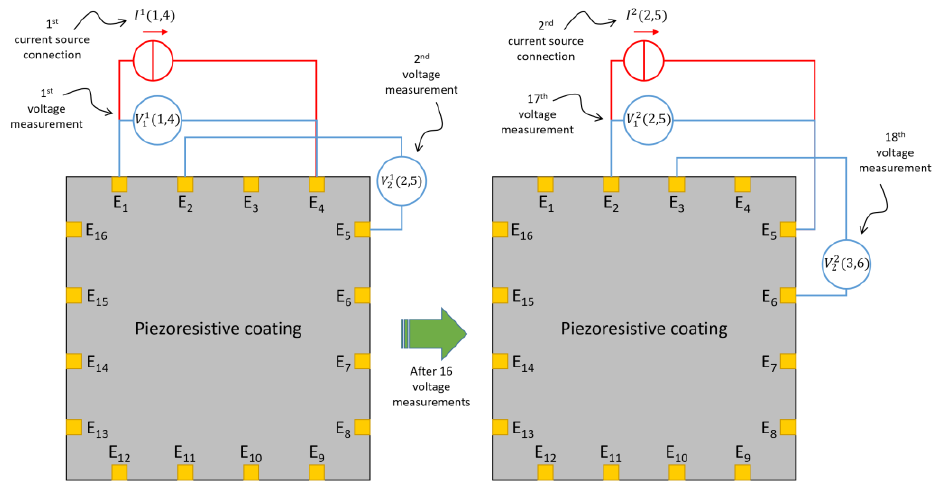
Figure 7. Sketches showing the adopted current injection–voltage measurement method. Only the current injection between two pairs of electrodes and two consecutive voltage measurements for each current source connection are represented for the sake of simplicity.